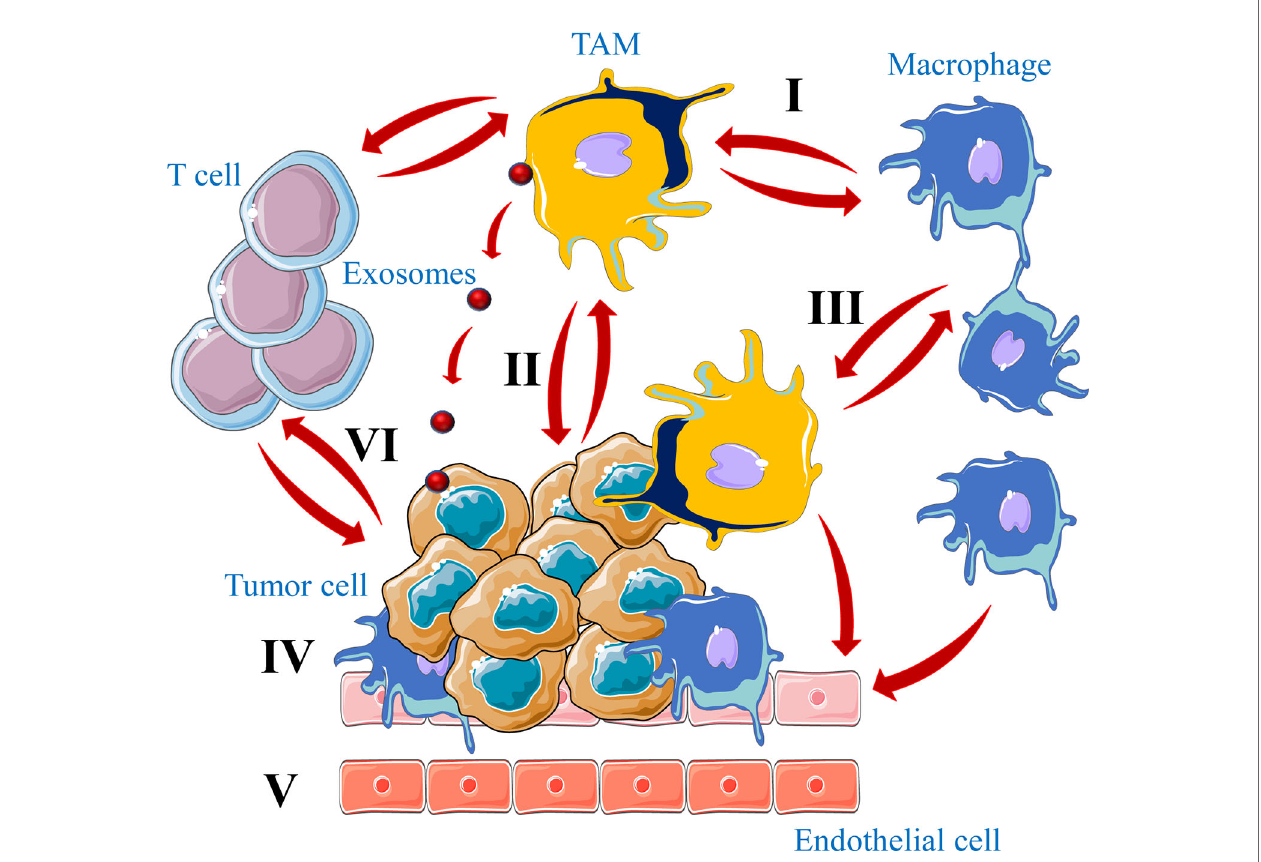
FIGURE 5 | Crosstalk between tumor cells and TAMs in tumors. Macrophages have the function of killing tumor cells (I). However, a large number of TAMs in fi ltrated in the tumor microenvironment not only kill tumor cells, but also promote tumor growth and metastasis (II). In the tumor microenvironment tumor cells secrete a large number of chemokines and cytokines to recruit macrophages into tumors and regulate their signaling pathway to induce M2 macrophages formation (III). Finally, TAMs differentiated into M2 type maintain tumor growth by promoting tumor cell growth (IV), angiogenesis (V) and immune cells repression (VI), through physical interaction, secreted molecules or